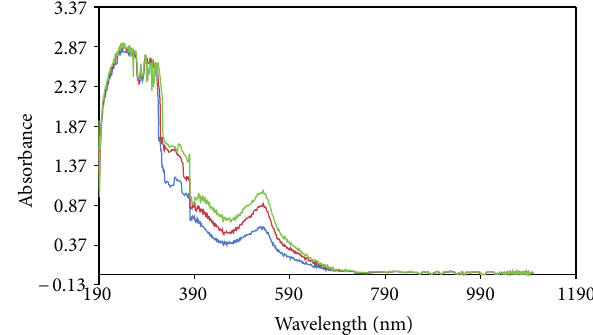
F5:UVspectrumshowingformationofintermediatecomplex at 534nm between IAA and PorFe v =O.